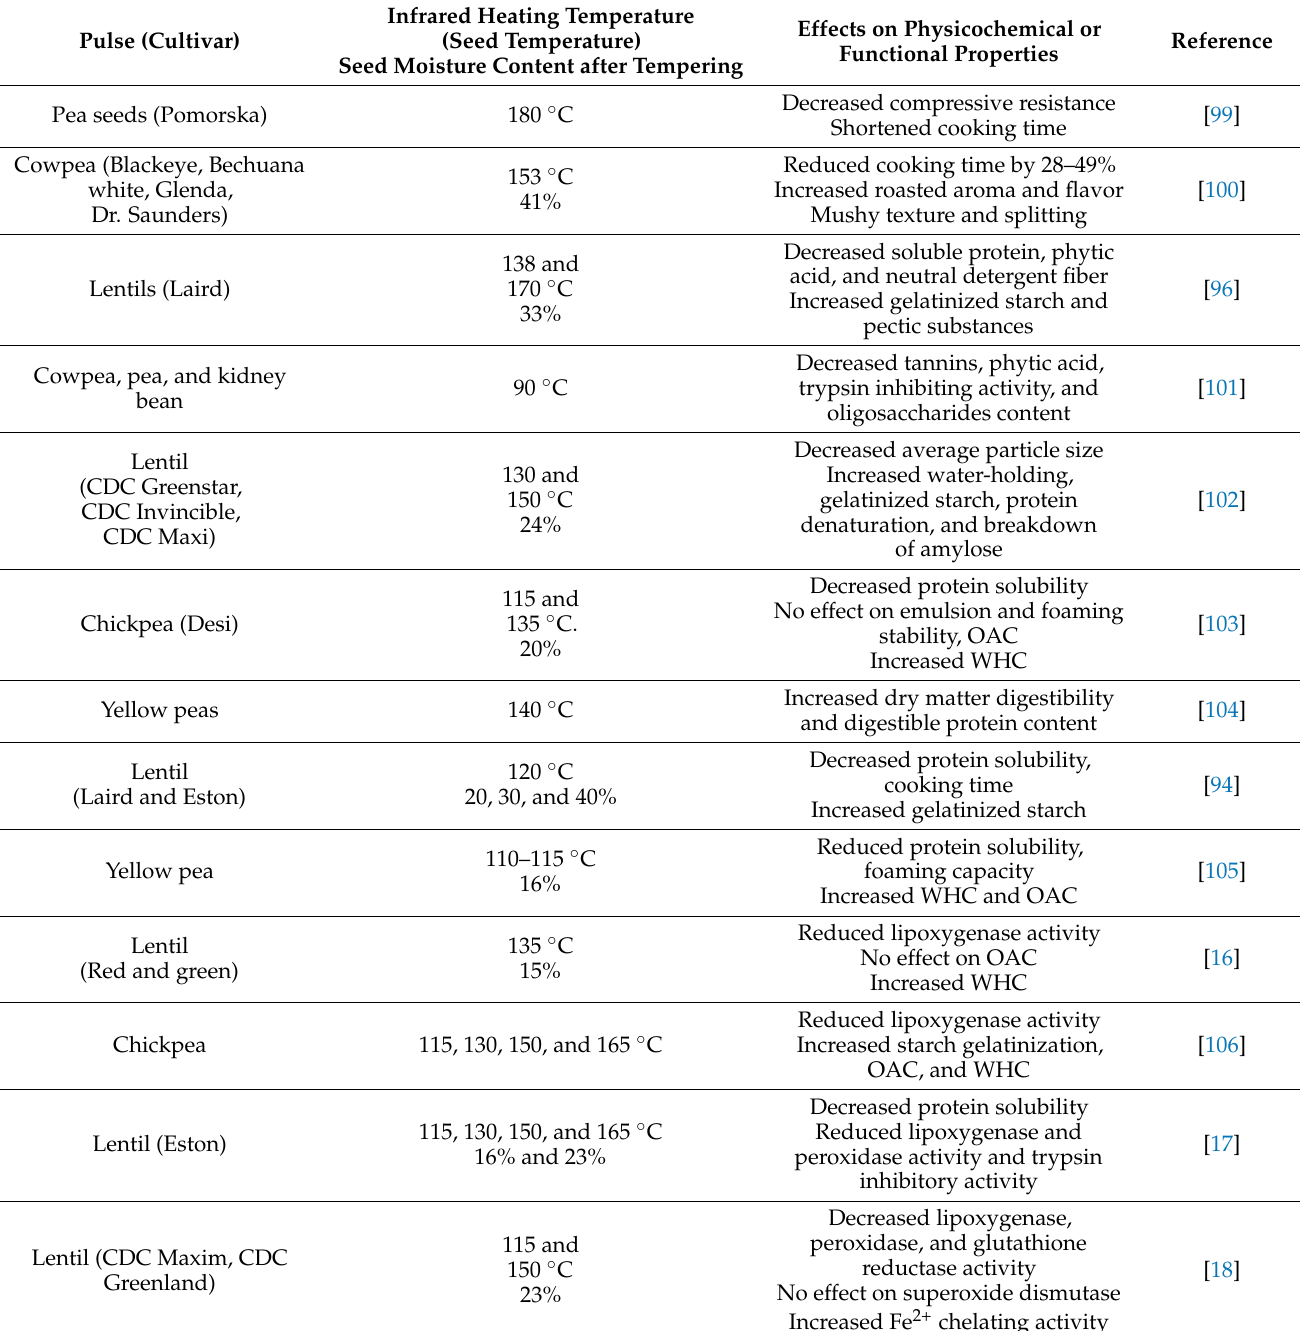
Table 4. Effects of infrared heating of pulses on their physicochemical or functional